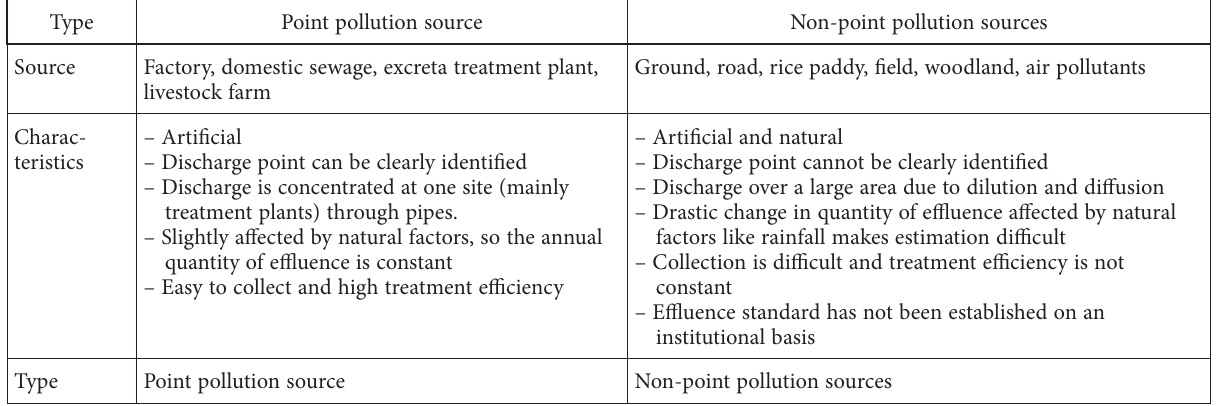
Table 1. Comparison between point and non-point pollution sources (Ministry of Environment, 2007)